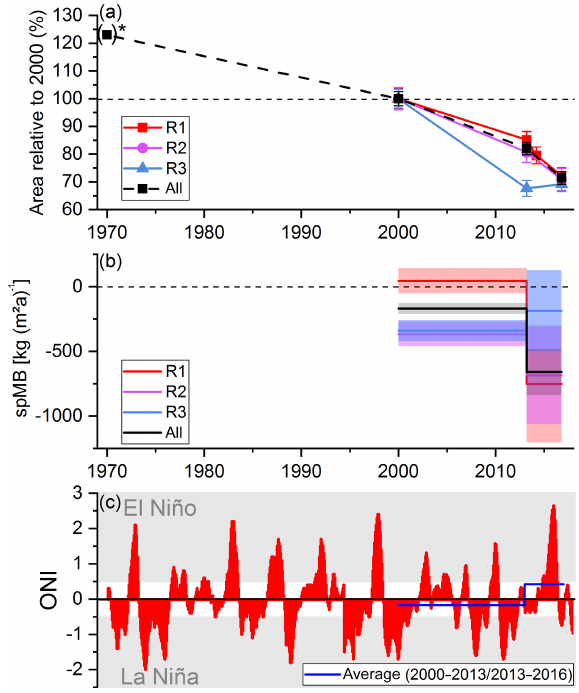
Figure 8. Temporal evolution of (a) relative glacier area changes, (b) observed specific mass balance (spMB; colour shaded areas represent the uncertainty of the corresponding measurements), and (c) Oceanic Nino Index (ONI) in the period 1970–2016. ∗ Area measurement in 1970 taken from the first Peruvian glacier inven- tory (Hidrandina SA, 1989) and only mountain ranges with com- plete coverage by the inventory in 1970 are considered in the area change computation (see also Sect.